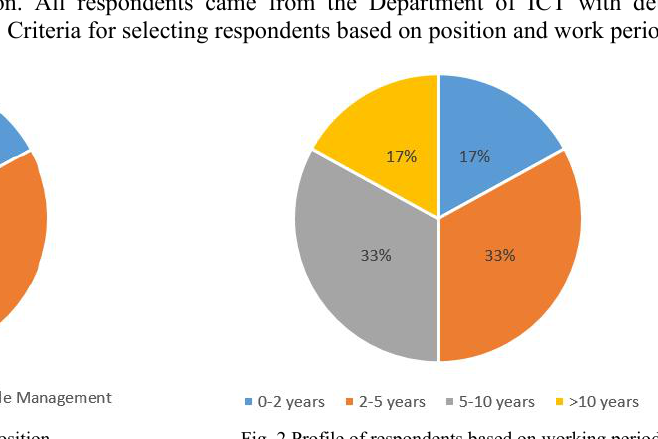
Fig. 1 Profile of respondents based on position Fig. 2 Profile of respondents based on working